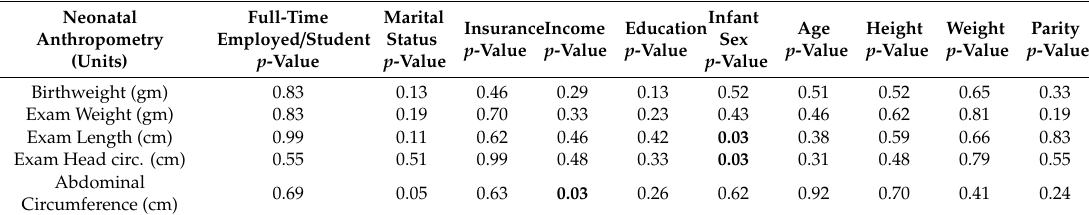
Table 4. Type III sum of squares p-values for race by socioeconomic interactions.